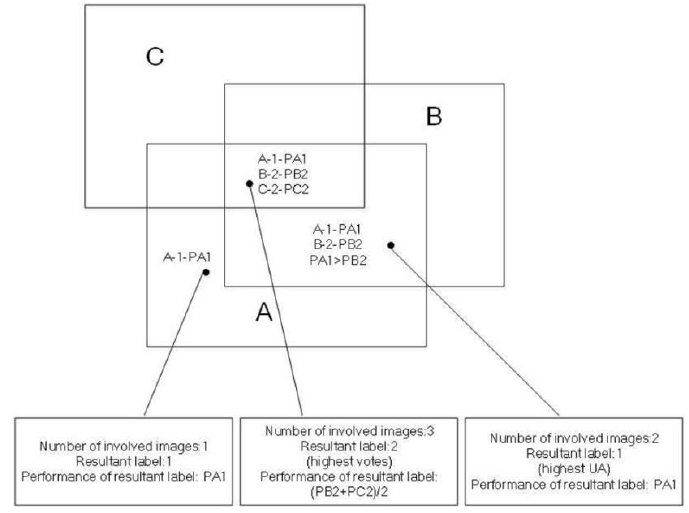
Figure 2. Voting scenarios.